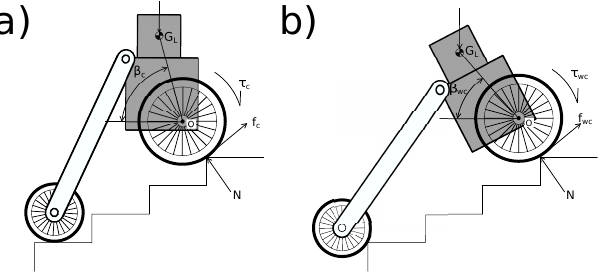
Figure 22. Robot schematic while ascending; ( a ) with control; ( b ) without